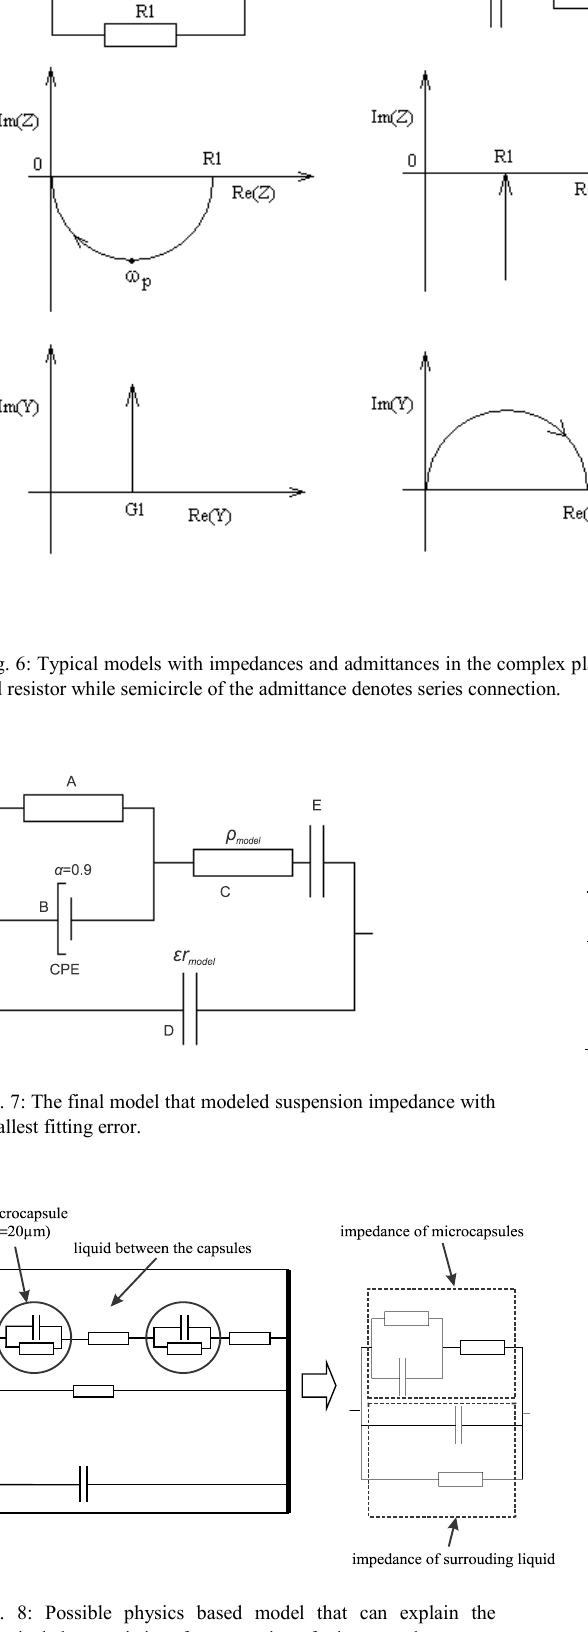
Fig. 8: Possible physics based model that can explain the electrical characteristics of a suspension of microcapsules.